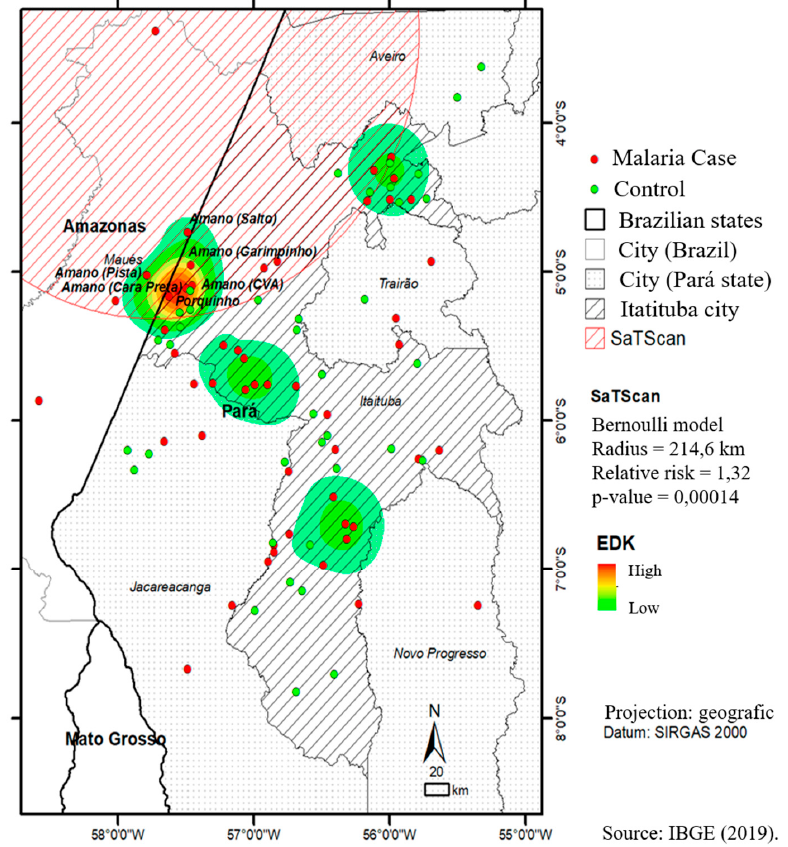
Figure 2. High and low risk clusters for malaria in the city of Itaituba, Pará, Brazilian Amazon.